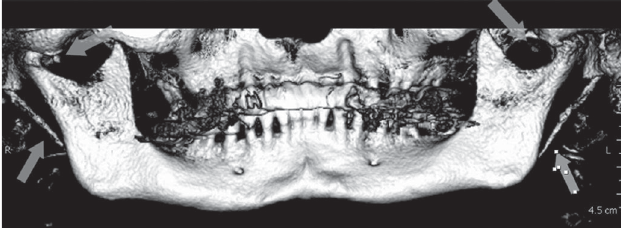
Fig. 4. Case 2. Panoramic view of CBVT. Arrows point to the bilateral loose bodies and both stylohyoid ligaments calcified and